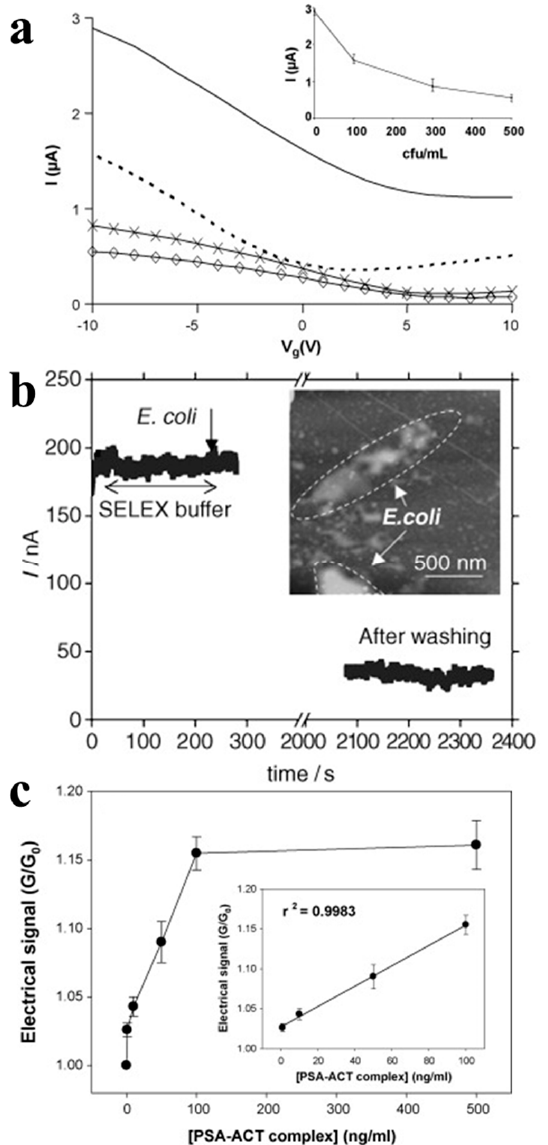
Figure 6. CNTFET-based sensors for cell detection. ( a ) From top to bottom, transfer curves before and after exposure to Salmonella with concentrations of 100 cfu/mL, 300 cfu/mL and 500 cfu/mL, respectively [73]. ( b ) Current change of the CNTFET for Escherichia coli detection [74]. ( c ) Prostate- specific antigen PSA-ACT complex detection on the CNTFETs modified with a 1:3 linker to spacer ratio [75].